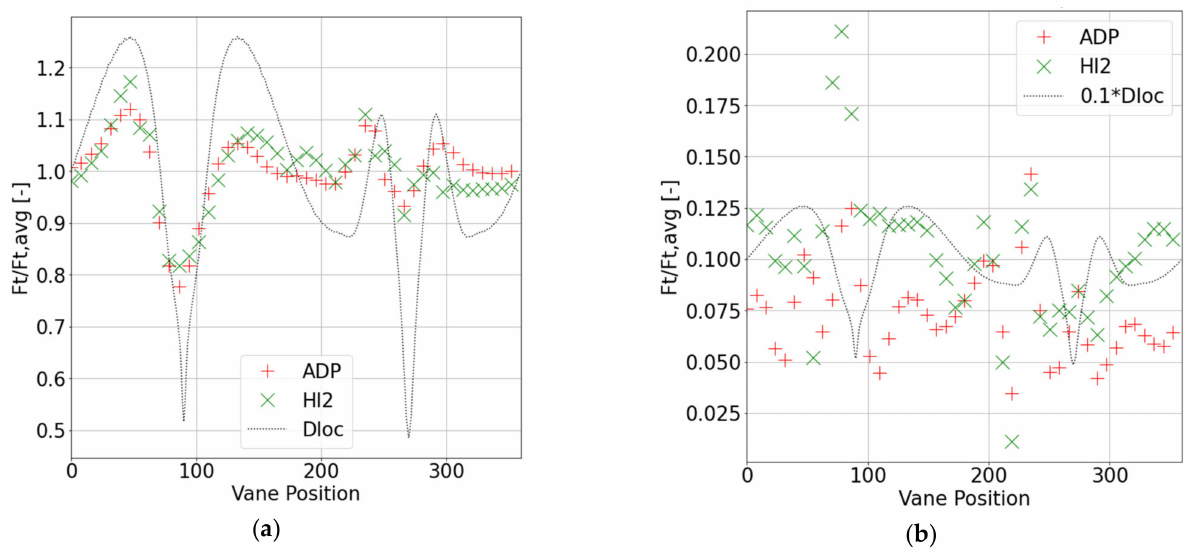
Figure 13. Normalized forces of the OGVs. ( a ) Time average variation per vane; ( b ) the 18/rev amplitude per